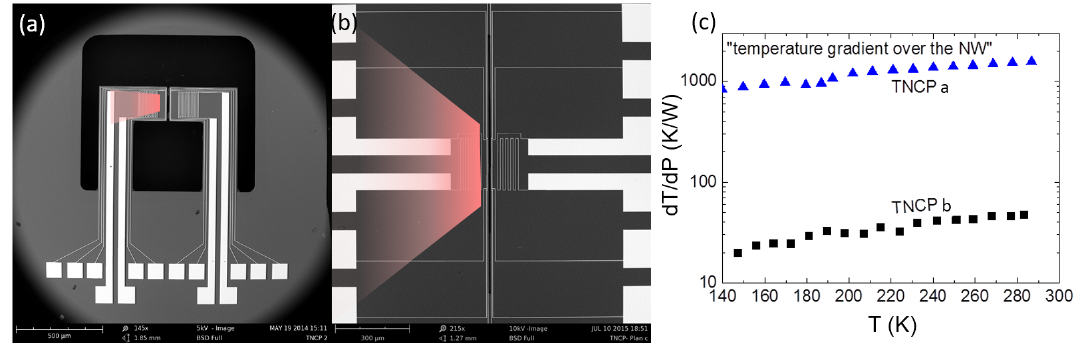
Figure 4. ( a , b ) The generated heat distribution in both platforms. Due to the design, heat is more concentrated in Platform a . ( c ) Temperature gradient across the nanowire site in both platforms.